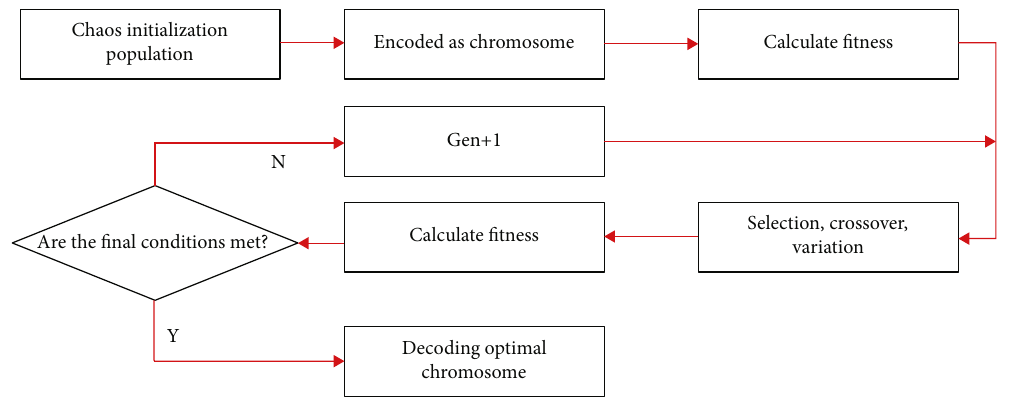
Figure 1: The running process of the genetic